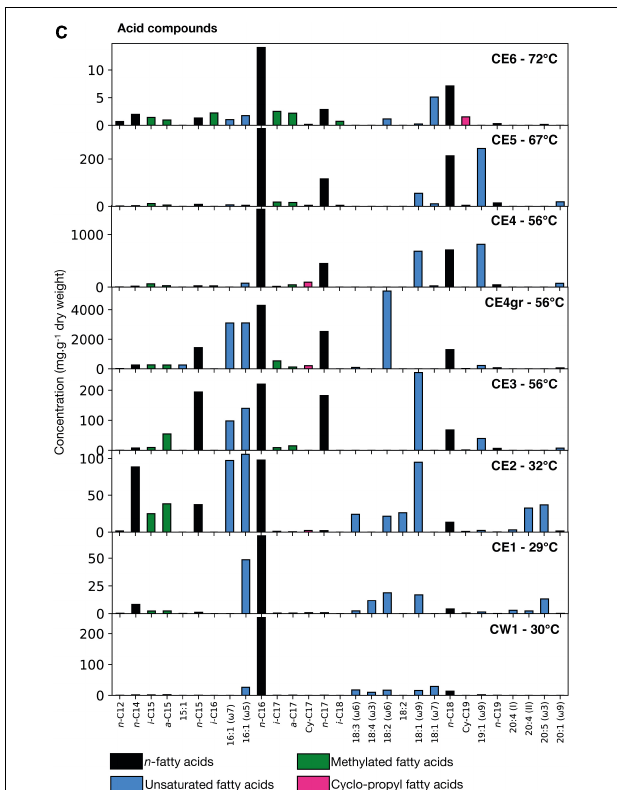
FIGURE 2 | Concentration (mg · g − 1 of dry weight) of the different lipid compounds identified in the eight Cacao biofilms along three polarity fractions; (A) apolar, (B) polar, and (C) acidic. Within each fraction, only the main compounds that represent more than 1% of the total mass concentration are plotted. Note that the vertical scale is different for each biofilm as the total concentration of organic matter varied between samples, and we focus on the relative distribution of lipid compounds. Different colors are used to represent different types of molecules (linear and saturated or normal chains, chains with double bonds or branches, aromatics, etc.). In the three panels, “unsaturated” compounds stand for chains with double bonds represented in the N:M format, where N indicates the number of carbons composing the chain and M the number of double bonds (e.g., 18:1 is a chain of 18 carbons with one double bond). In (B) the “phytol and derivatives” category includes neophytadiene and dihydrophytol besides phytol. In (C) iso and anteiso compounds ( i -/ a -) are monomethylated chains with one methyl group at the N-1 or N-2 carbon, respectively. In (C) , the position of the double bond is defined using the omega notation, that is, the position starting from the final carbon. In (C) Cy-C N corresponds to mid-chain cyclo-propyl compounds, with chains of N carbons. The raw mass chromatograms used for compound identification and building the bar plots are available in the Supplementary Figure 3